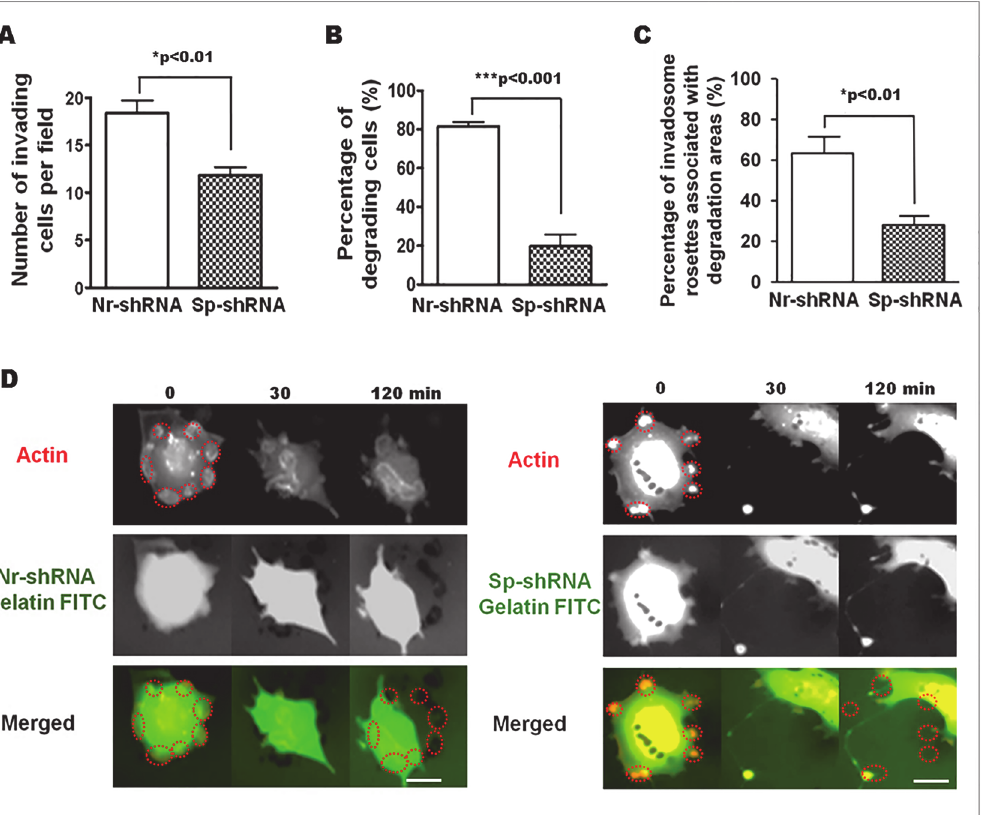
Fig 6. Knockdown of α II-spectrin decreases cell invasion and matrix degradation activity of invadosomes. (A) SrcY527F-MEF were transfected for 72 hr with shRNAs (Nr-shRNA and Sp-shRNA) and seeded on Boyden ’ s chamber coated with a layer of Matrigel in order to obtain an invasion chamber. Around 15 random fields were analyzed per condition and results are presented as pool of three different experiments. After 20 hr, the number of invasive cells was significantly reduced by 35% when spectrin was silenced (Nr-shRNA 18,40 vs. Nr-shRNA 11,85 p < 0,01). (B) This decrease of the invasive properties of SrcY527F-MEF depleted for α II-spectrin was associated with a large decrease in the percentage of cells able to digest an extracellular matrix component such as FITC-gelatin (Nr-shRNA 81.53 ± 2.31% vs. Sp-shRNA 19.67 ± 6.17%; p < 0,001). (C) More precisely, the percentage of invadosome rings associated with a degradation area was significantly reduced in spectrin-depleted cells (Nr-shRNA 63.25 ± 6.70% vs. Sp-shRNA 28.15 ± 3.00%; p < 0.01). (D) Extracted images from time series (min) from representative observations of living SrcY527F-MEFcells transfected for 72 hr with shRNAs (Nr- shRNA and Sp-shRNA) and Ruby-LifeAct. Spectrin depletion impairs matrix degradation as shown by the lack of black areas (Sp-shRNA, 120 min) in the red circles, indicating invadosomes at time 0. Scale bar: 20 μ